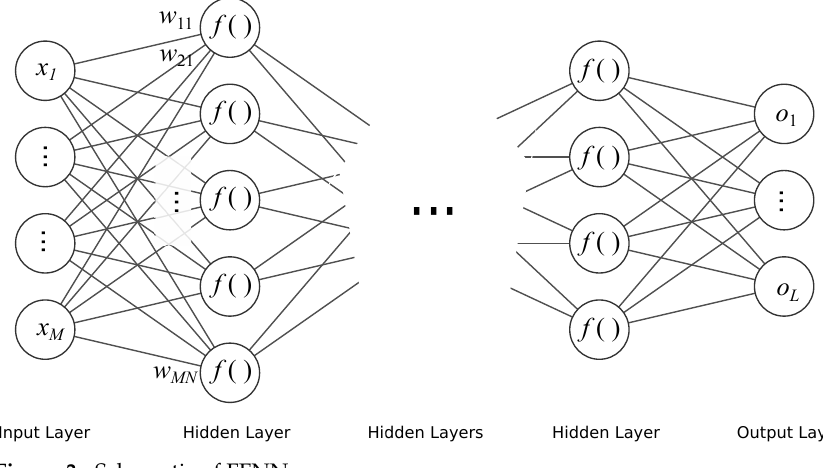
Figure 3. Schematic of